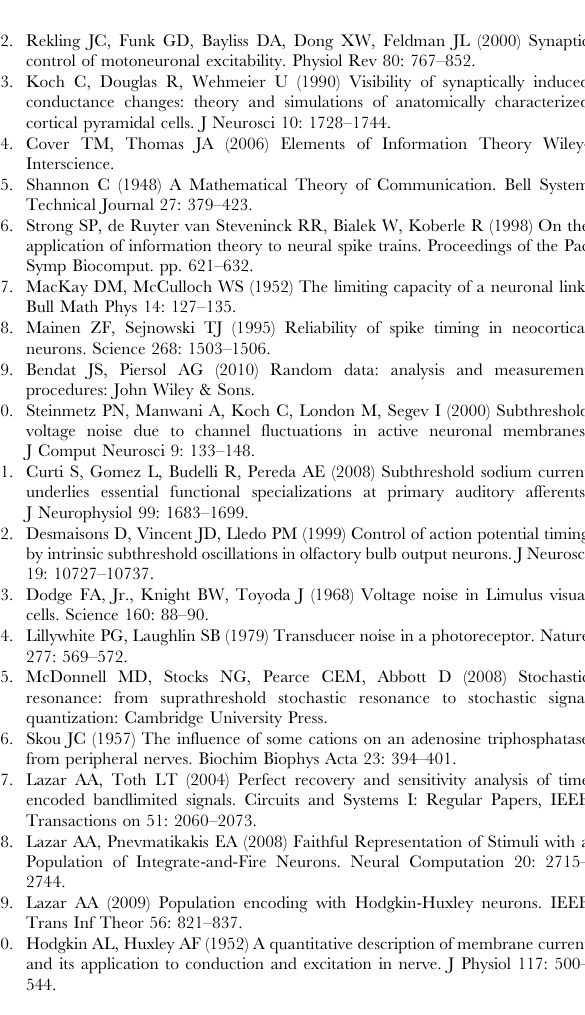
with different means and standard deviations. The Signal-to-Noise ratio (SNR) of the input was fixed at 2. Figure S5 Extrinsic noise reduces mutual information in spike trains, pseudo-generator potentials and graded potentials. A. Introduction of extrinsic noise with SNR = 2 causes a 40% decrease in mutual information in the spiking responses. B. Similarly, there is a decrease of up to 60% in the pseudo-generator potentials in response to inputs with SNR= 2. C. Over a wide variety of inputs, the mutual information is decreased up to 70% in the graded potentials with the introduction of extrinsic noise. Figure S6 The numbers of open K + channels and the membrane potential range determines the energy consumption of pseudo-generator potentials. A. Joint kernel density estimates of open K + channels and the membrane potential in response to low mean, low standard deviation stimulus, and B. low mean, high standard deviation stimulus. C. Joint kernel density estimates of open K + channels and the membrane potential in response to high mean, low standard deviation stimulus, and D. high mean, high standard deviation stimulus.